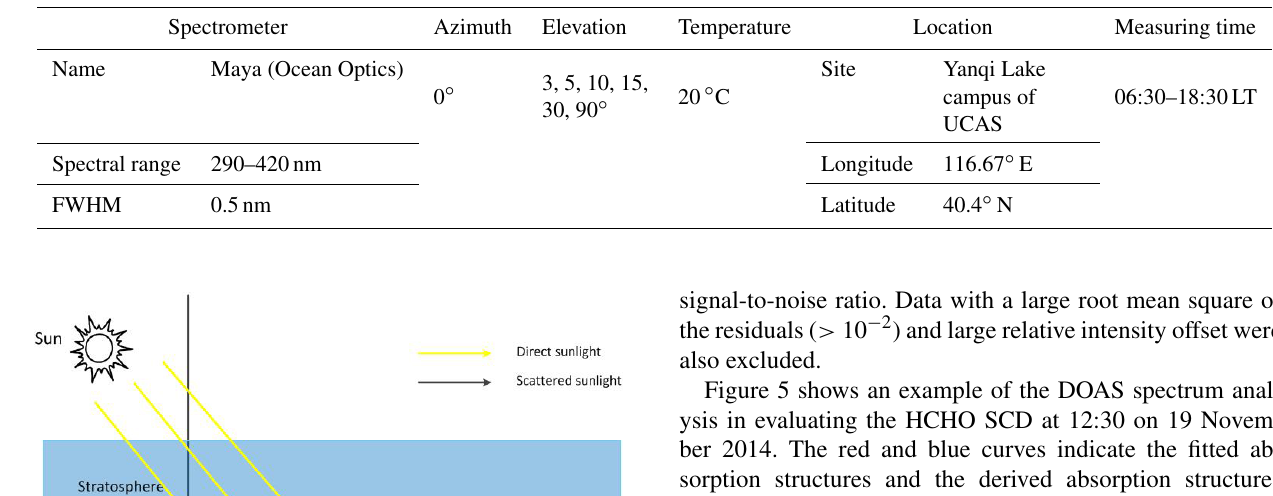
Table 1. Setup of MAX-DOAS.